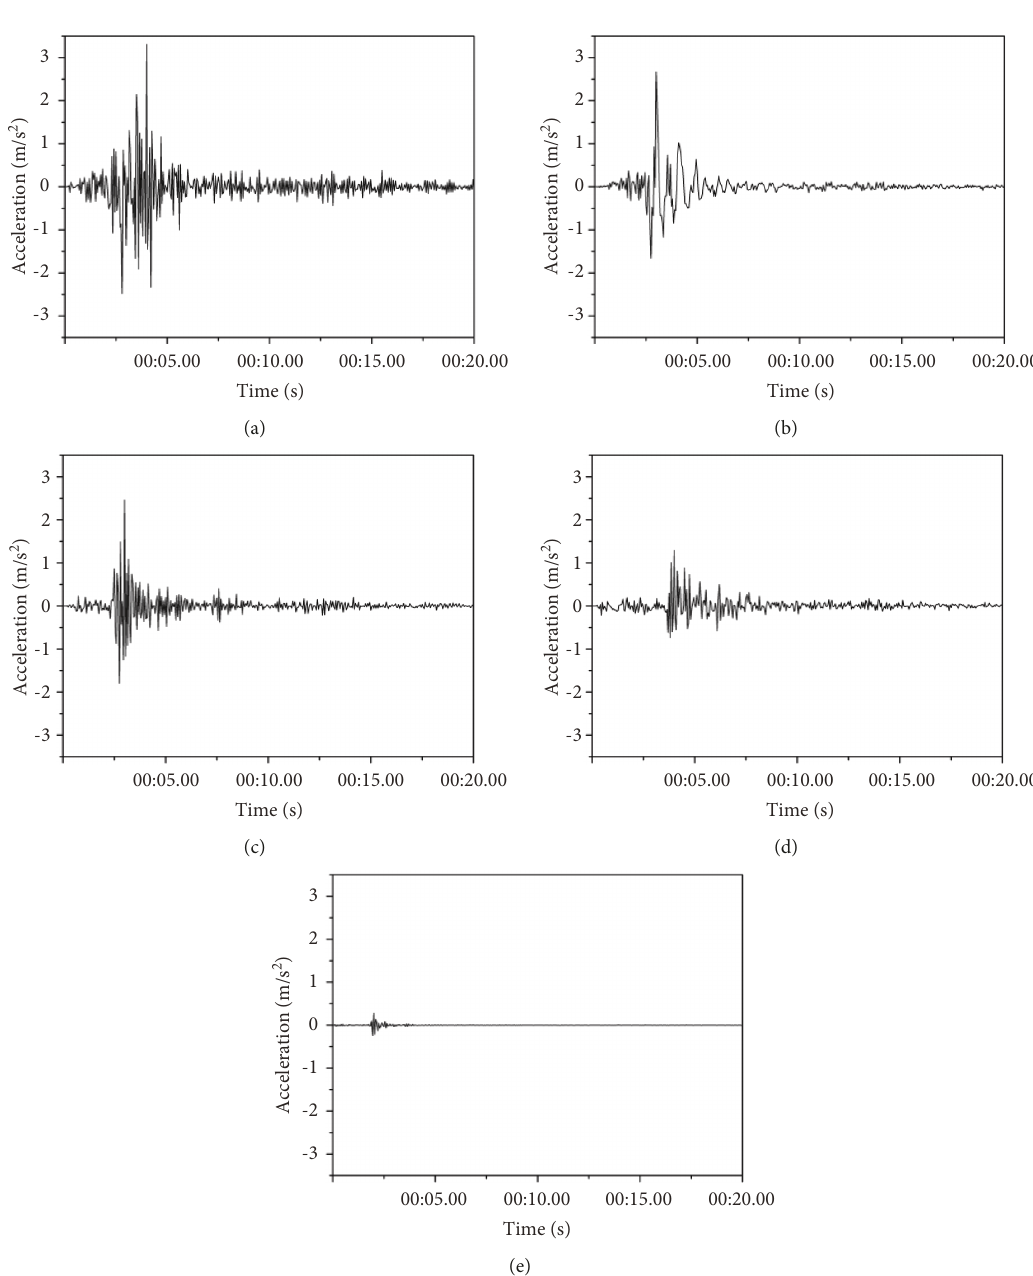
Figure 3: Seismic waveforms for the five earthquakes used in the time-history analysis. Time 0 corresponds to the first arrival. The PGA and degree of waveform fluctuations generally increased as the earthquake magnitude increased (see Table 3 for the details of each earthquake). (a) M5.8 earthquake. (b) M5.4 earthquake. (c) M5.1 earthquake. (d) M3.9 earthquake. (e) M3.0